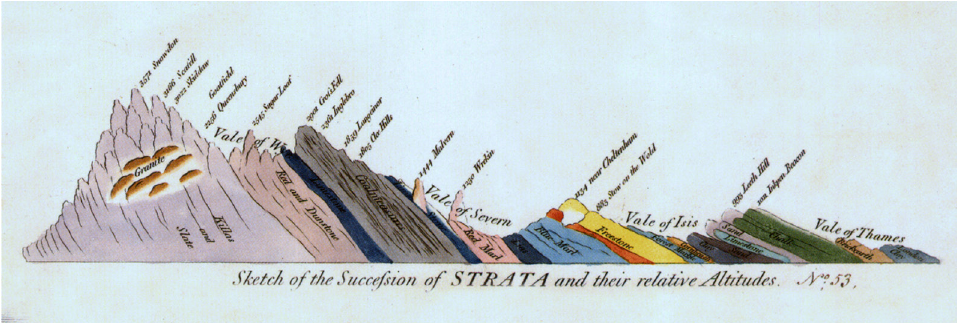
Fig. 6. A geological section of rock strata on the map A Delineation of the Strata of England and Wales with Part of Scotland ... by W. Smith, 1815 (from the collection of The Geological Society of